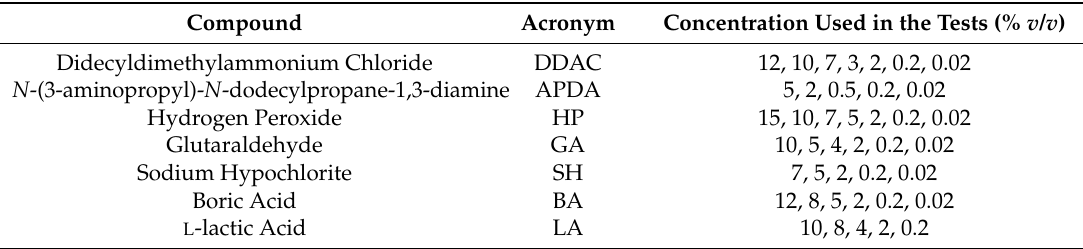
Table 4. Active chemical compound of